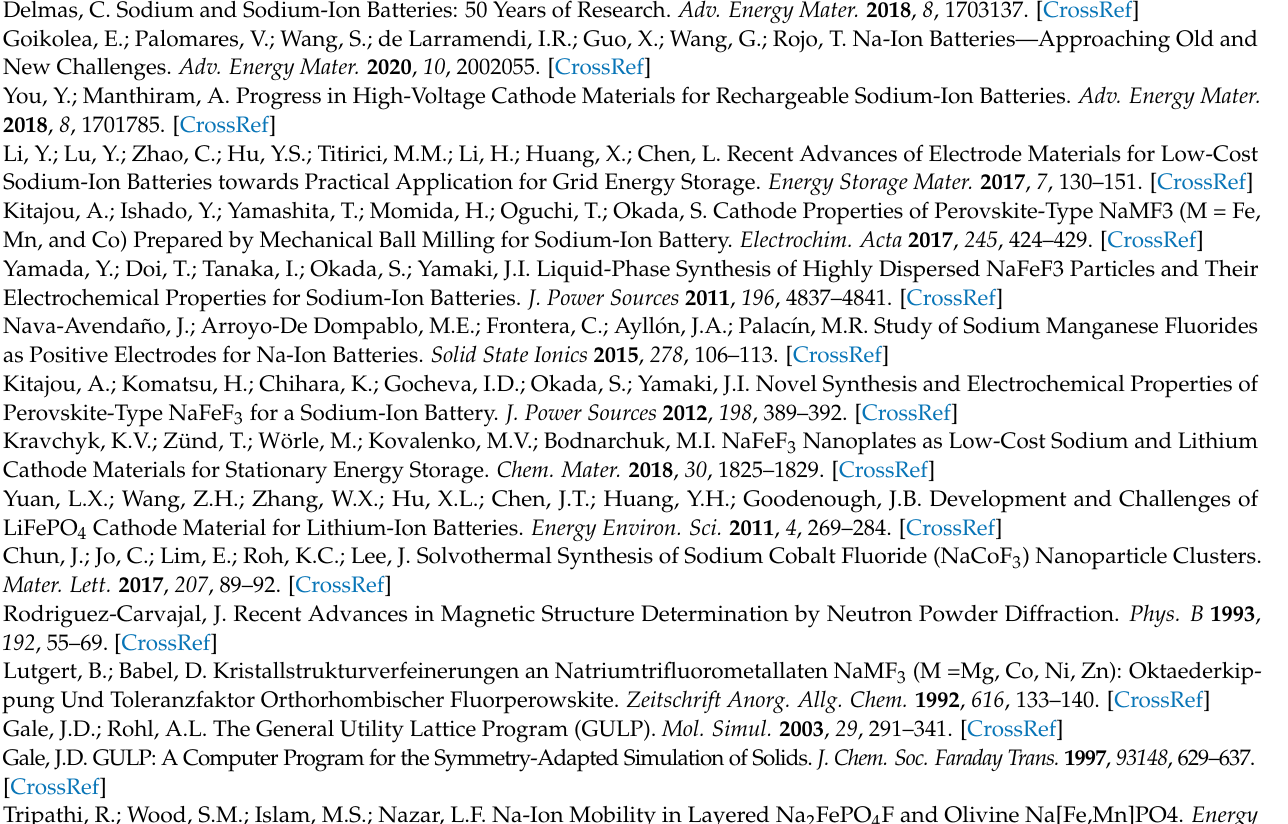
NaCo 1-x Mn x F 3 ; Table S1: Rietveld refined structural parameters; Table S2: Pair potential (Buckingham functional) and shell model parameters; Table S3: Comparison between calculated and experimental structural